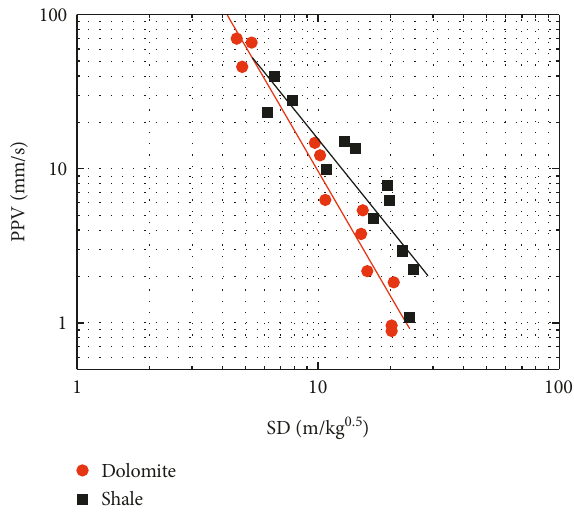
Figure 8: Scaled distance versus PPV of different positions at Baideng